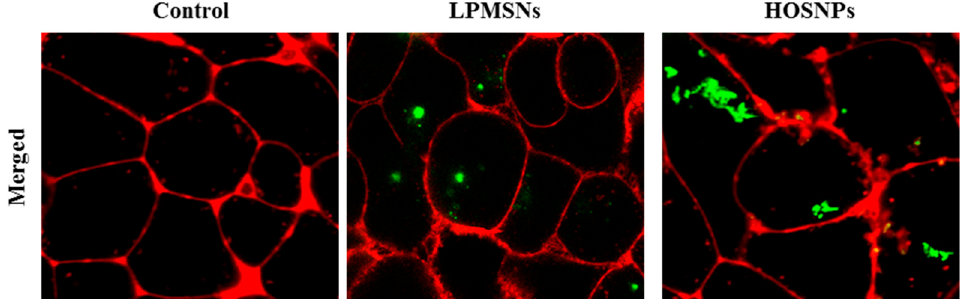
Figure 4. Fluorescence confocal imaging of live MCF-7 cells incubated for 24 h with LPMSNs or HOSNPs. The presence of the NPs is marked by green dots and membranes of cells appear in red.